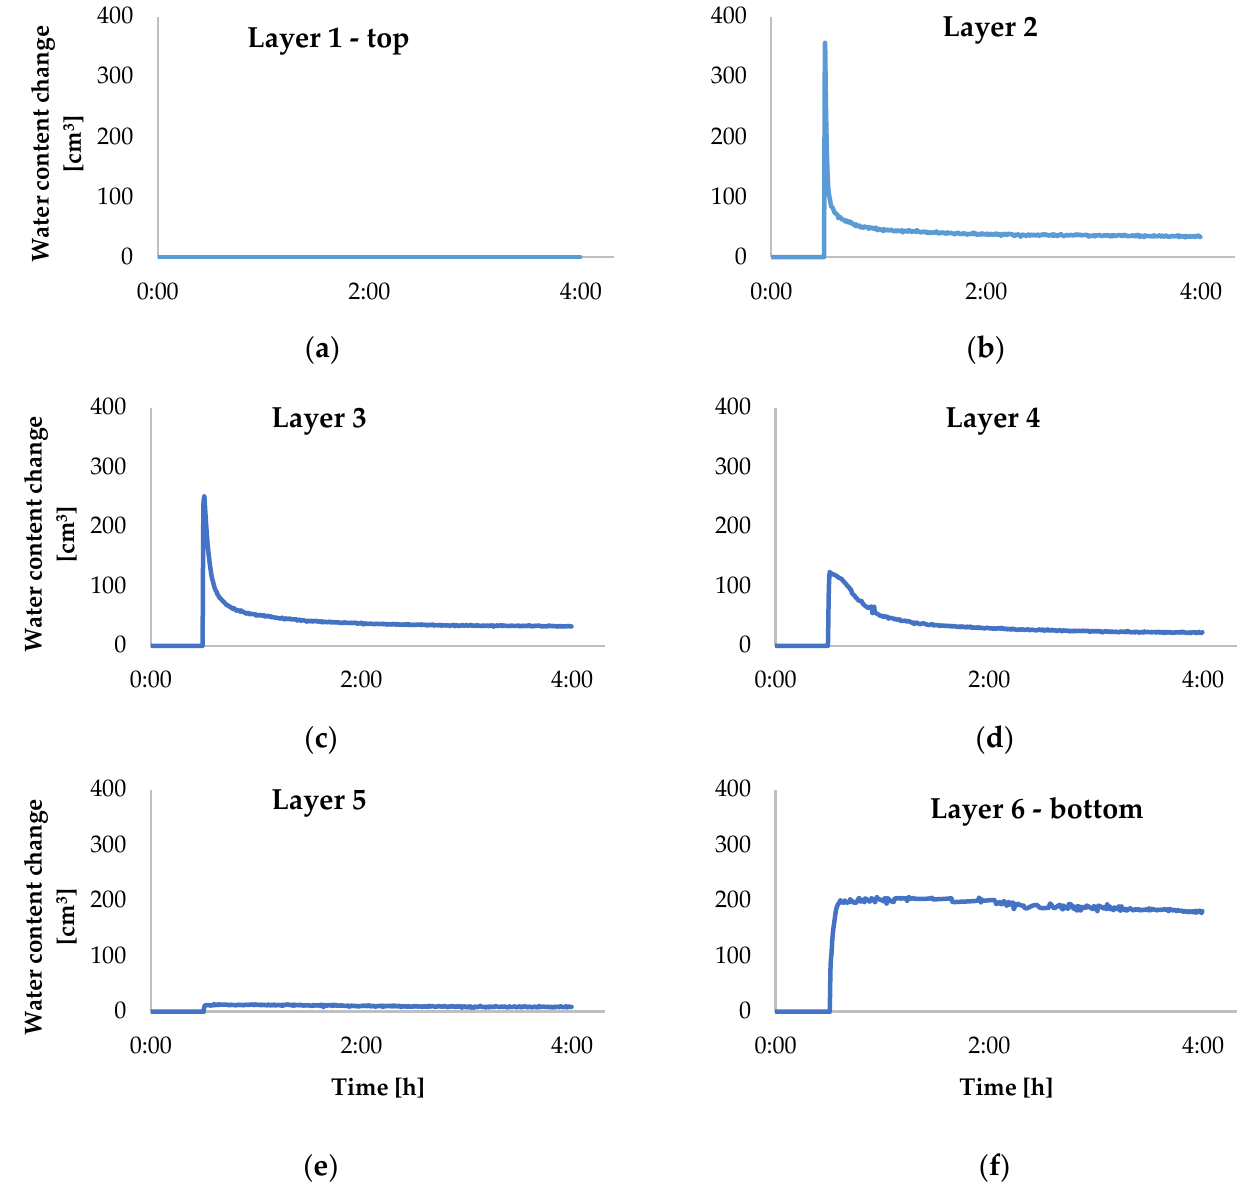
Figure 9. Changes of water content in sand monolith during the injection of 750 cm 3 of water, in a 4-h time interval, in the individual layers: ( a ) – layer 1, ( b ) – layer 2, ( c ) – layer 3, ( d ) – layer 4, ( e ) – layer 5, ( f ) – layer 6. The layers were presented in Figure 4.